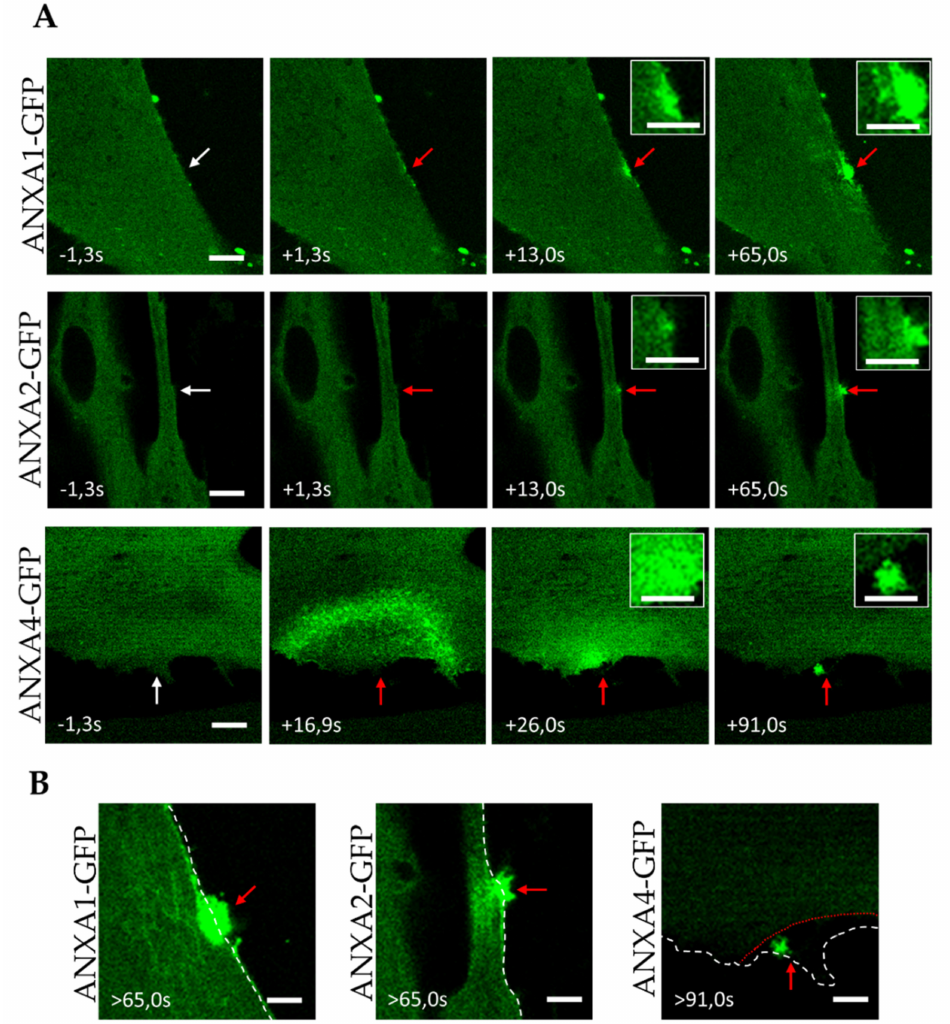
Figure 2. Recruitment of ANX to the site of membrane injury and formation of the cap subdomain in myotubes. ( A ) LHCN myotubes were transfected with the plasmid pA1-GFP, pA2-GFP or pA4-GFP and membrane damages were performed by laser ablation. White arrow, area before irradiation; red arrow, area after irradiation. Insets display magnified images of the membrane disruption site. Scale bar for images and insets, respectively: 10 µ m and 5 µ m. ( B ) Magnified images of the damaged myotubes presented in ( A ) more than 65 s after laser injury. The white and red dotted lines display the position of the sarcolemma before and after (if different) laser ablation, respectively. Scale bar: 5 µ